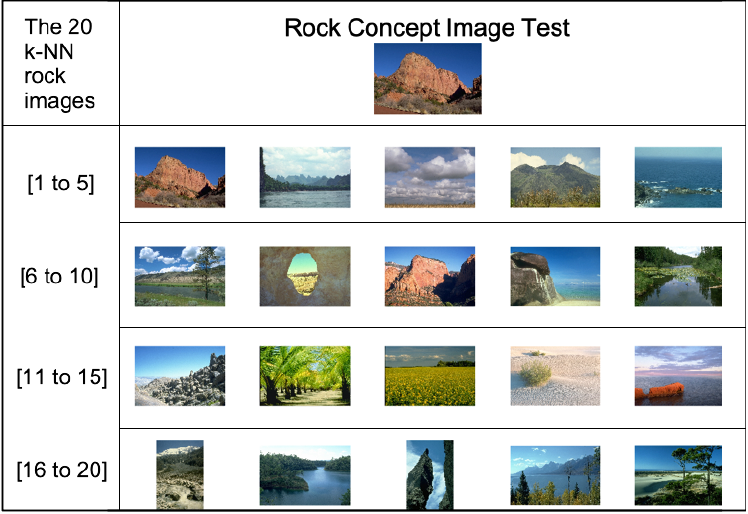
Figure 18. Retrieval results related to the concept of rock.